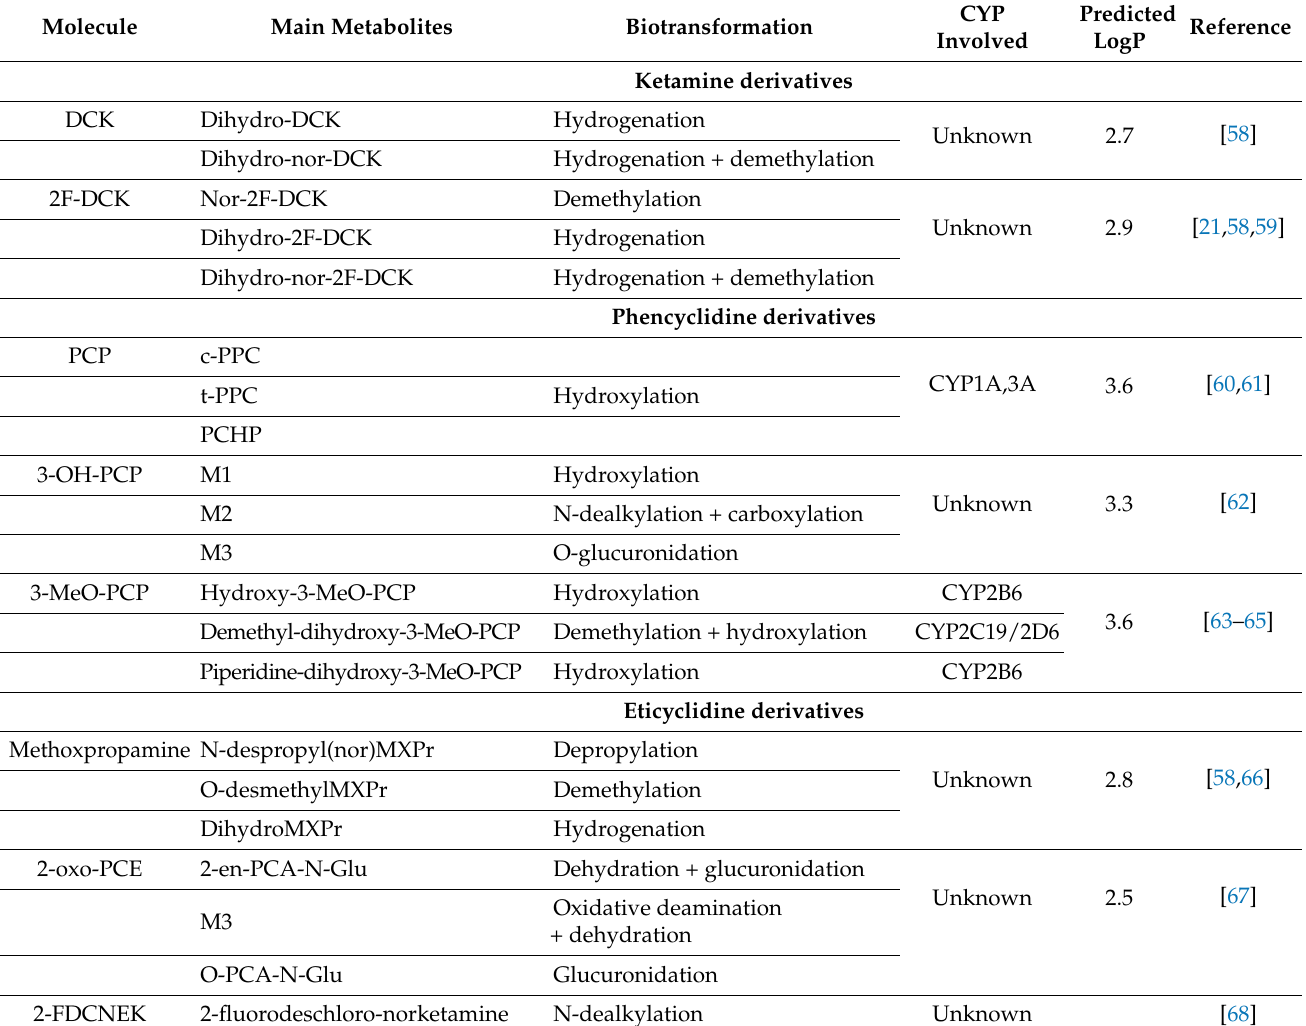
Table 1. The metabolic fate of ACH